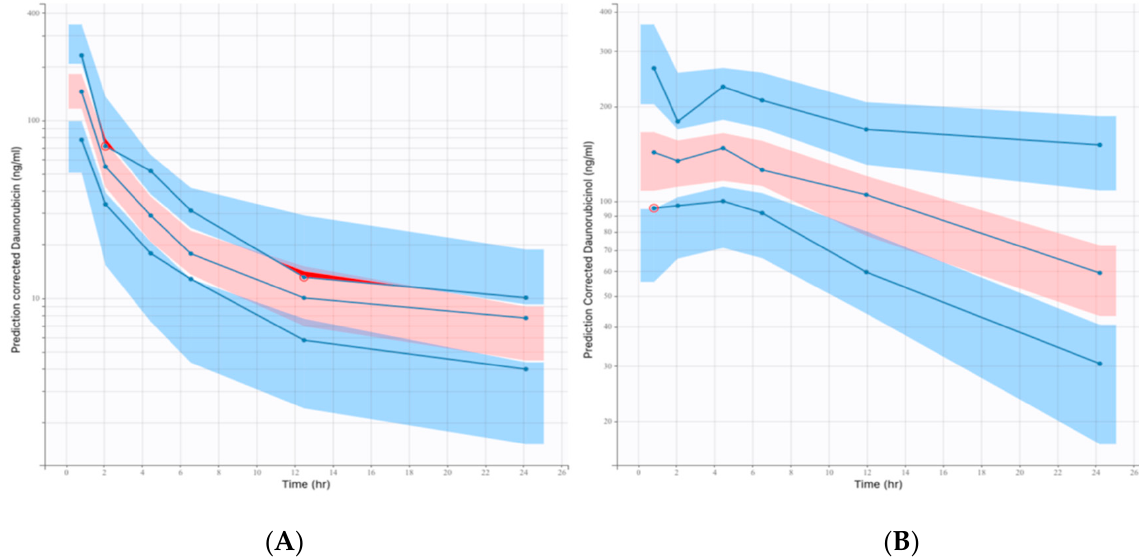
Figure 4. Prediction-corrected visual predictive checks (pcVPC) graphs. The red-shaded area is the 95% confidence interval (CI) of the median prediction. The blue-shaded areas are 10th–90th per- centiles of prediction interval. Blue curves are the empirical percentiles. ( A ) pcVPC of the final full PK model for daunorubicin concentration evolution over time; ( B ) pcVPC of the final full PK model for daunorubicinol concentration evolution over time.